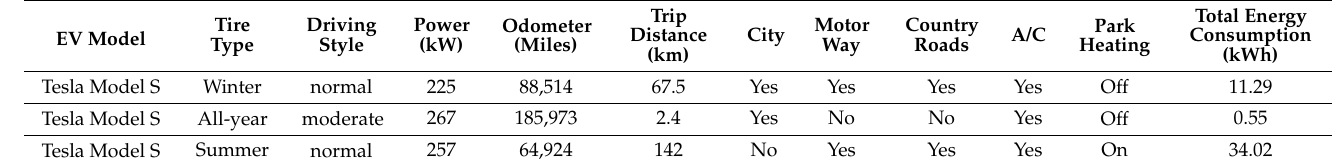
Table 1. Input dataset with independent variables and dependent variable